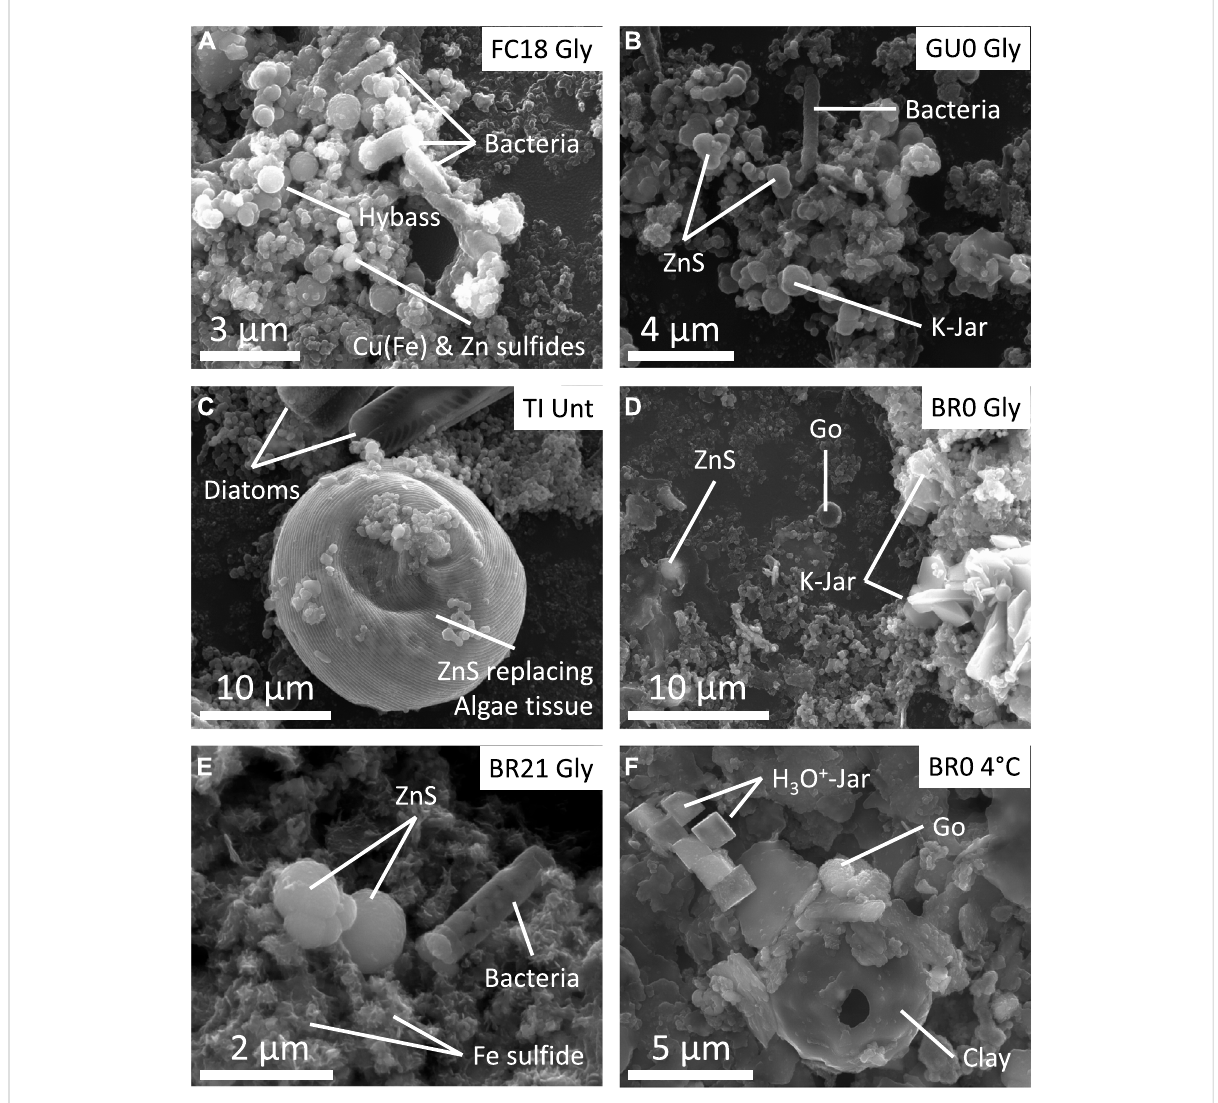
FIGURE 7 Scanning electron microscope (SEM) micrographs of different samples extracted from IC at different incubation states. (A) Abundant fossilized microbial cells surrounded by hydrobasaluminite (Hybass), Zn, Cu and/or Cu-Fe sul fi des from the black layer of FC18 (monimolimnion) IC. (B) Abundantmicrobialmolds surroundedbyK-jarosite, hydrobasaluminite,Cuand Znsul fi des. (C) Algaetissueshowingaconsiderablereplacementby Zn sul fi des and diatoms from TI untreated column. (D) Dark turbidity sample from BR0 amended IC, showing the presence of goethite (Go), jarosite (Jar) and Zn sul fi de. (E) Zn and Fe sul fi des, as well as fossilized microbial cells in the sediment sample from BR21 amended IC. (F) Fe precipitates (goethite and H 3 O + -Jarosite) from BR0 4 ° C stored